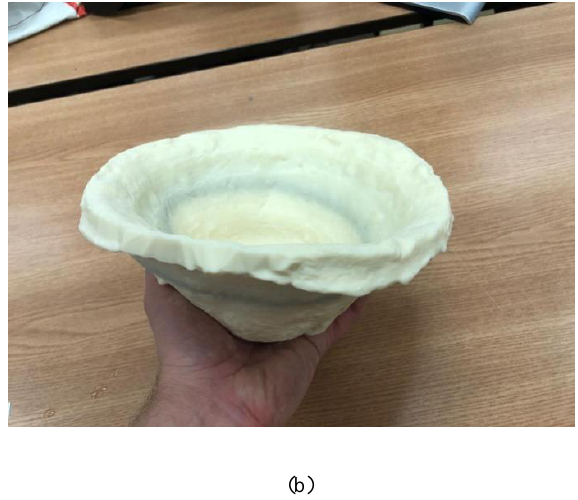
Figure 13. Creation of the final model; the assumed rotational symmetry of the finding was used (three millions of triangles)